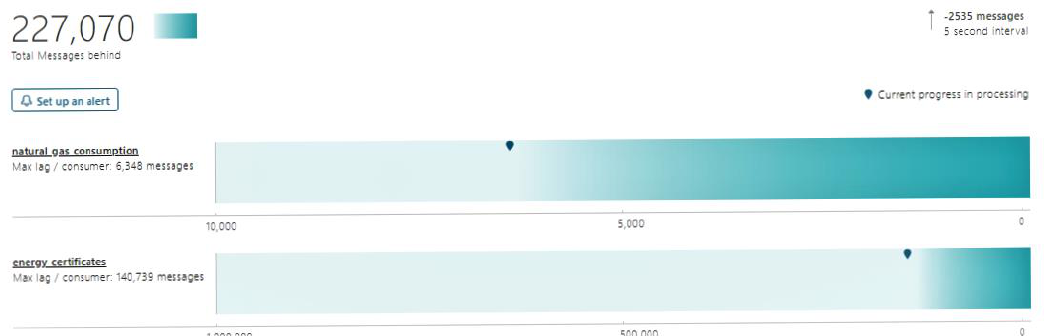
Figure 6. Data received from Reasoning Engine Kafka consumer.